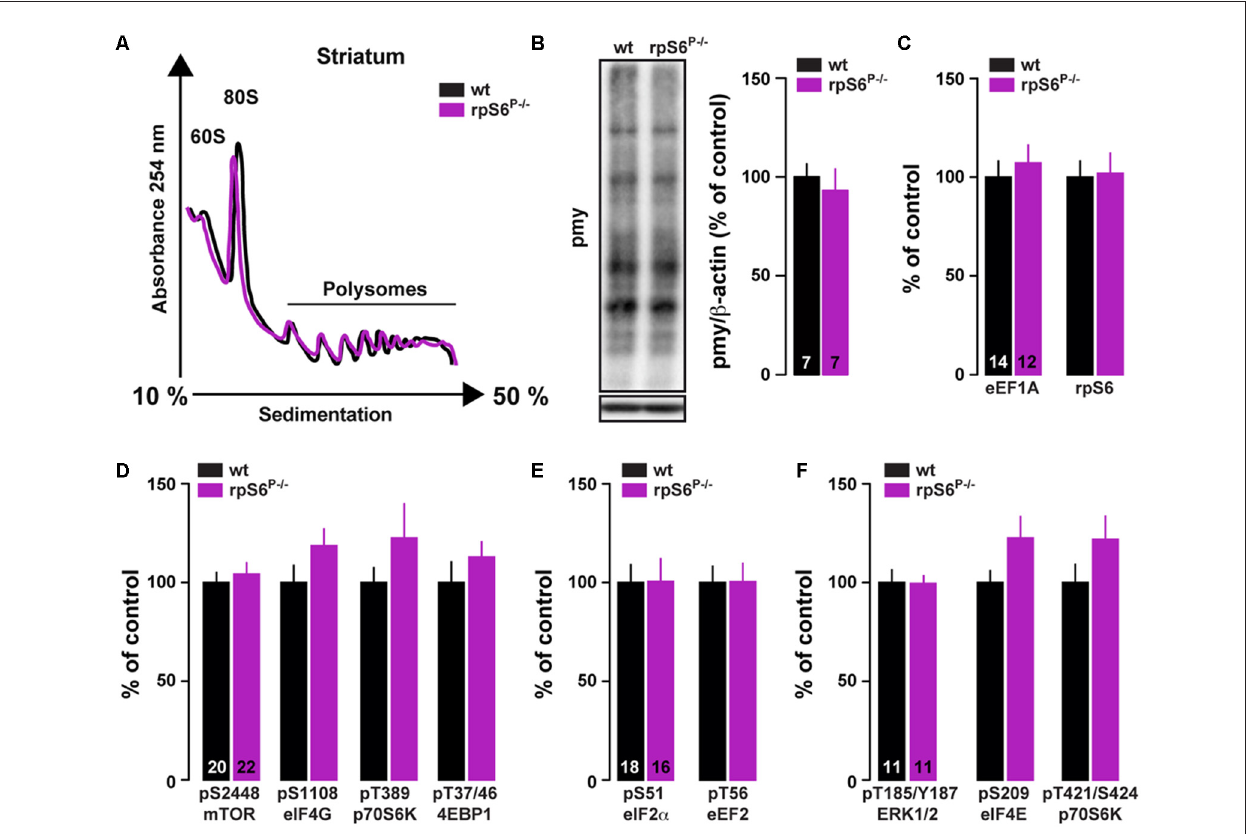
FIGURE 4 | Analysis of global mRNA translation in the striatum of rpS6 P − / − mice. (A) Representative polysome profile of whole striatum lysates from wt (black line) and rpS6 P − / − (magenta line) mice ( n = 6 mice/group). (B) Representative (left) and quantified (right) western blot analysis of puromycin staining (pmy, normalized to β -actin) in whole striatal lysates from wt (black bars) and rpS6 P − / − (magenta bars) mice incubated 10 min with puromycin. Results are represented as means ± SEM ( n and p values in Supplementary Table S1:4b). (C–F) Quantified western blot analysis of eE1A and rpS6 (C) , pS2448-mTOR, pS1108-eIF4G, pT389-p70S6K and pT37/46-4EBP1 (D) , pS51-eIF2 α and pT56-eEF2 (E) , pT185/Y187-ERK1/2, pS209-eIF4E and pT421/S424-pS70S6K (F) in total striatal lysates from wt (black bars) and rpS6 P − / − (magenta bars) mice. The number of animals in each condition is indicated in the bars. Results are represented as means ± SEM ( n and p values in Supplementary Table